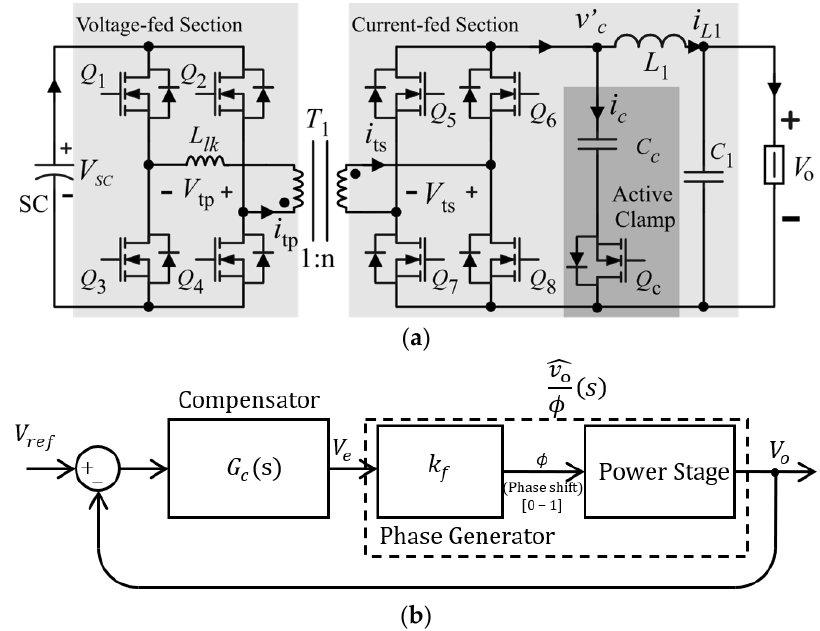
Figure 3. Submodule: ( a ) bidirectional full-bridge circuit, ( b ) inner control loop.